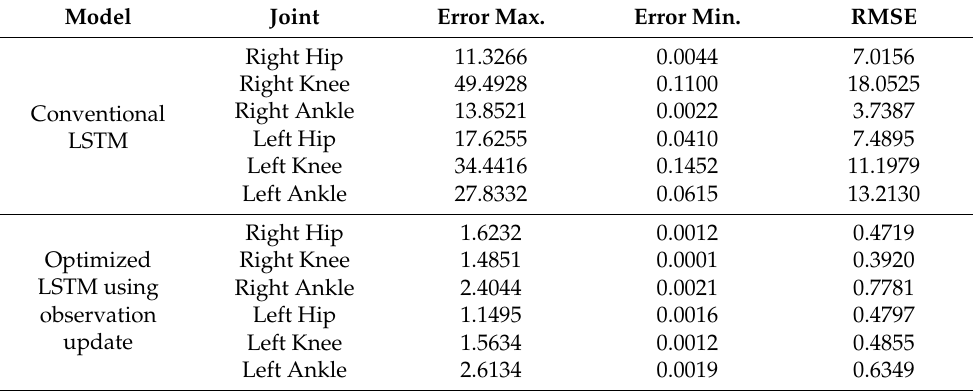
Table 1. The prediction result comparison of two models.